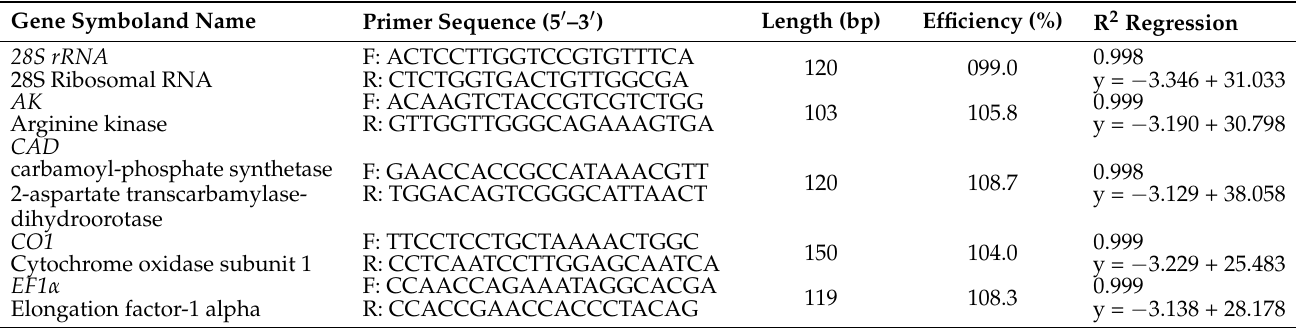
Table 1. RT-qPCR primers used for five reference genes in X. germanus